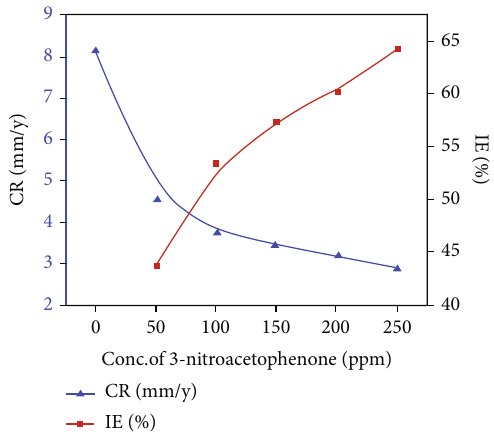
Figure 1: Corrosion rates and inhibition e ffi ciencies of 3-NA from weight loss